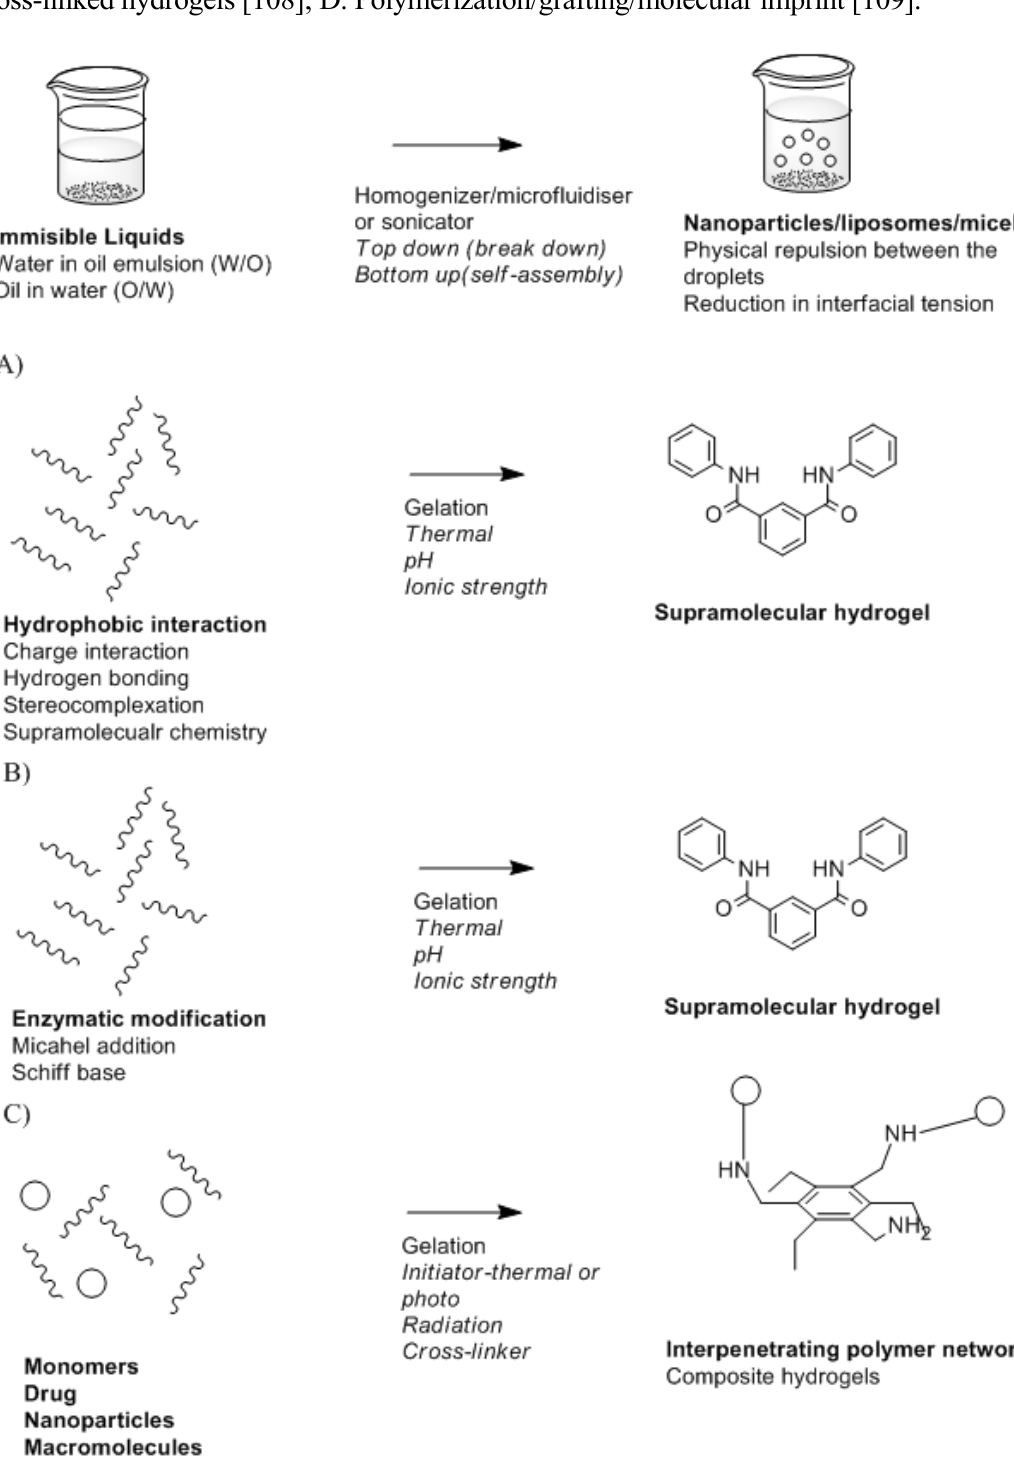
Figure 10. Different modes of drug delivery system synthesis. A.